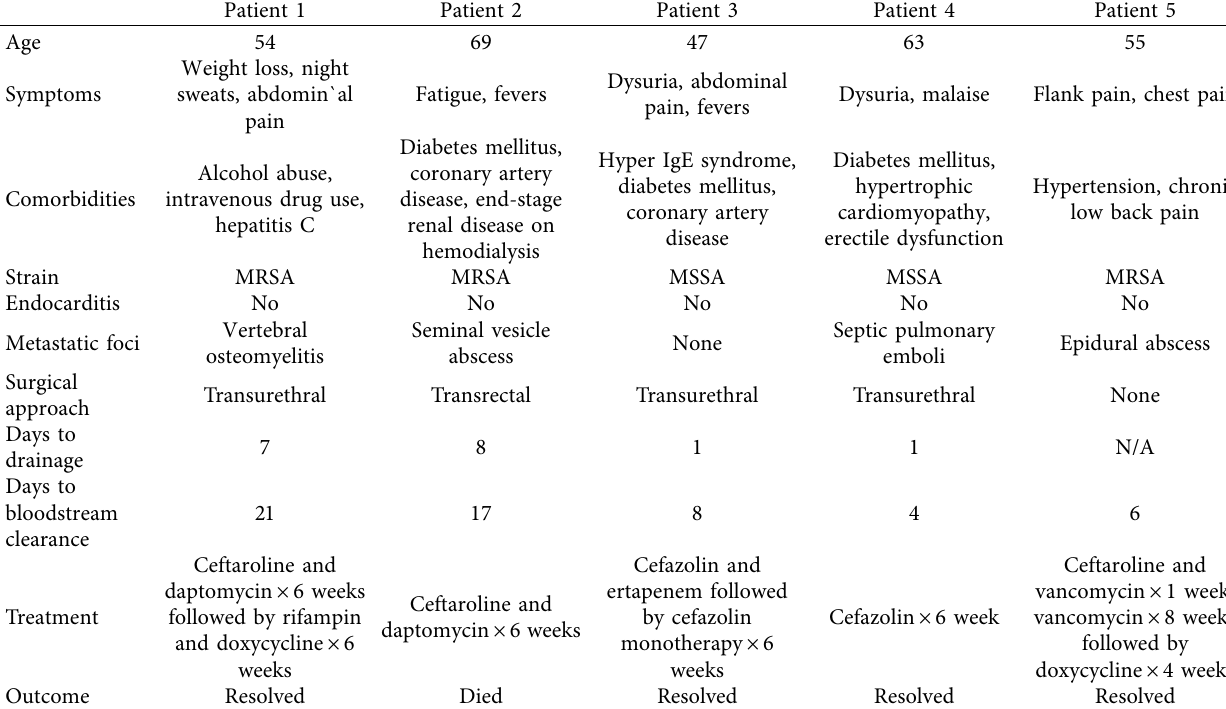
Table 1: Clinical characteristics and outcomes of five patients with S. aureus bacteremia and prostatic